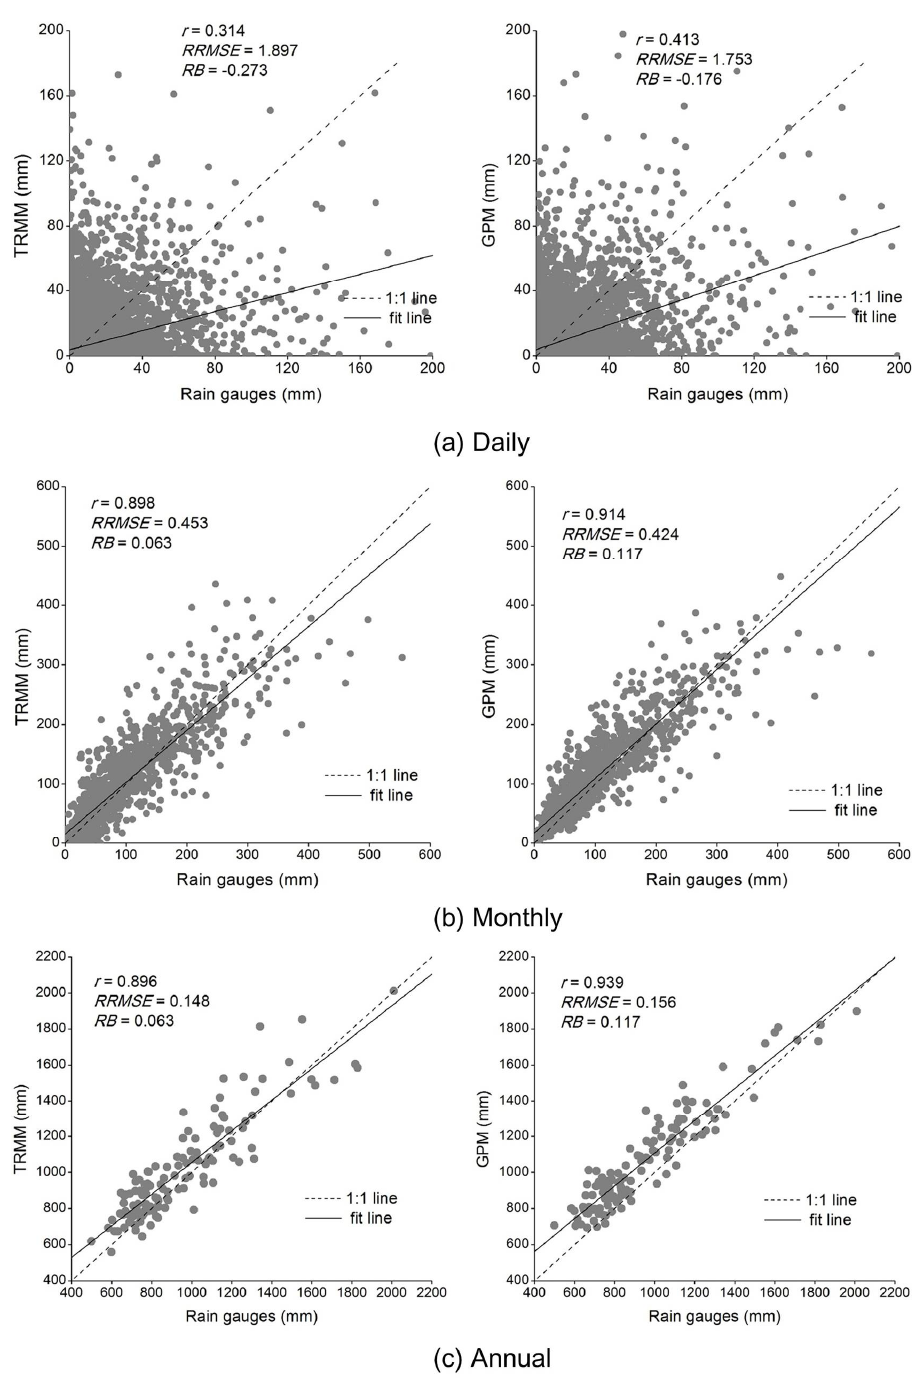
Figure 2. Scatterplots for TRMM 3B42 v7 and GPM IMERG v5 precipitation versus gauge measurements from 2015 to 2017 over the Huaihe River basin: ( a – c ) daily, monthly, and annual scales, respectively.